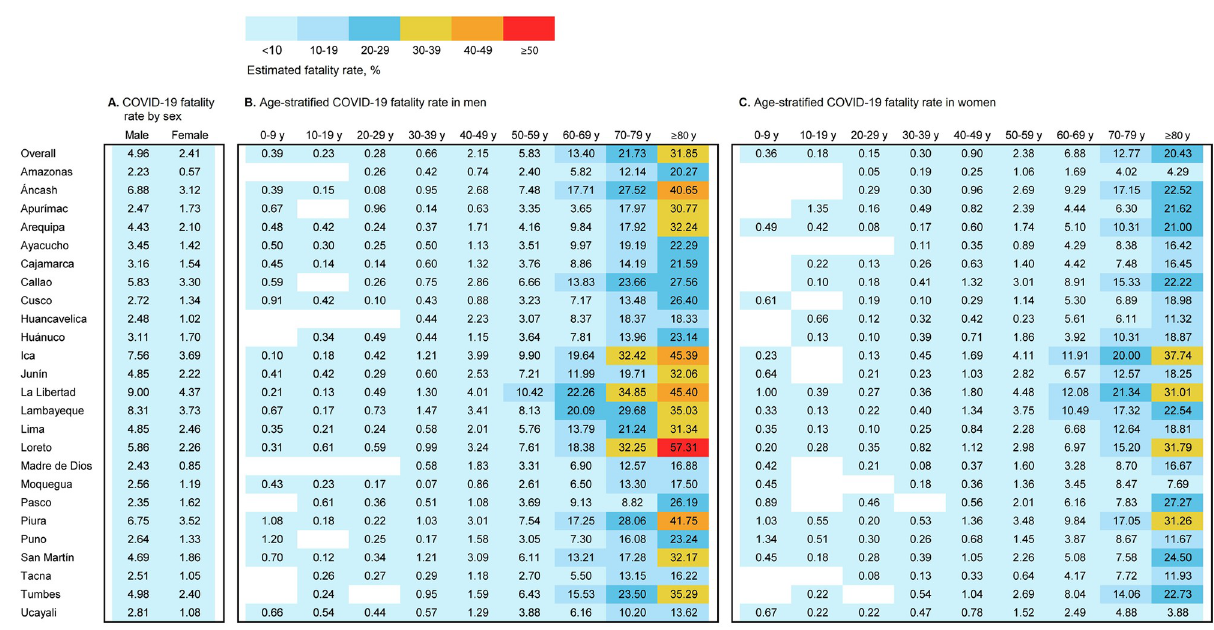
Fig 3. Sex and age-stratified COVID-19 fatality estimates by region (A, B and C), Peru, 2020.